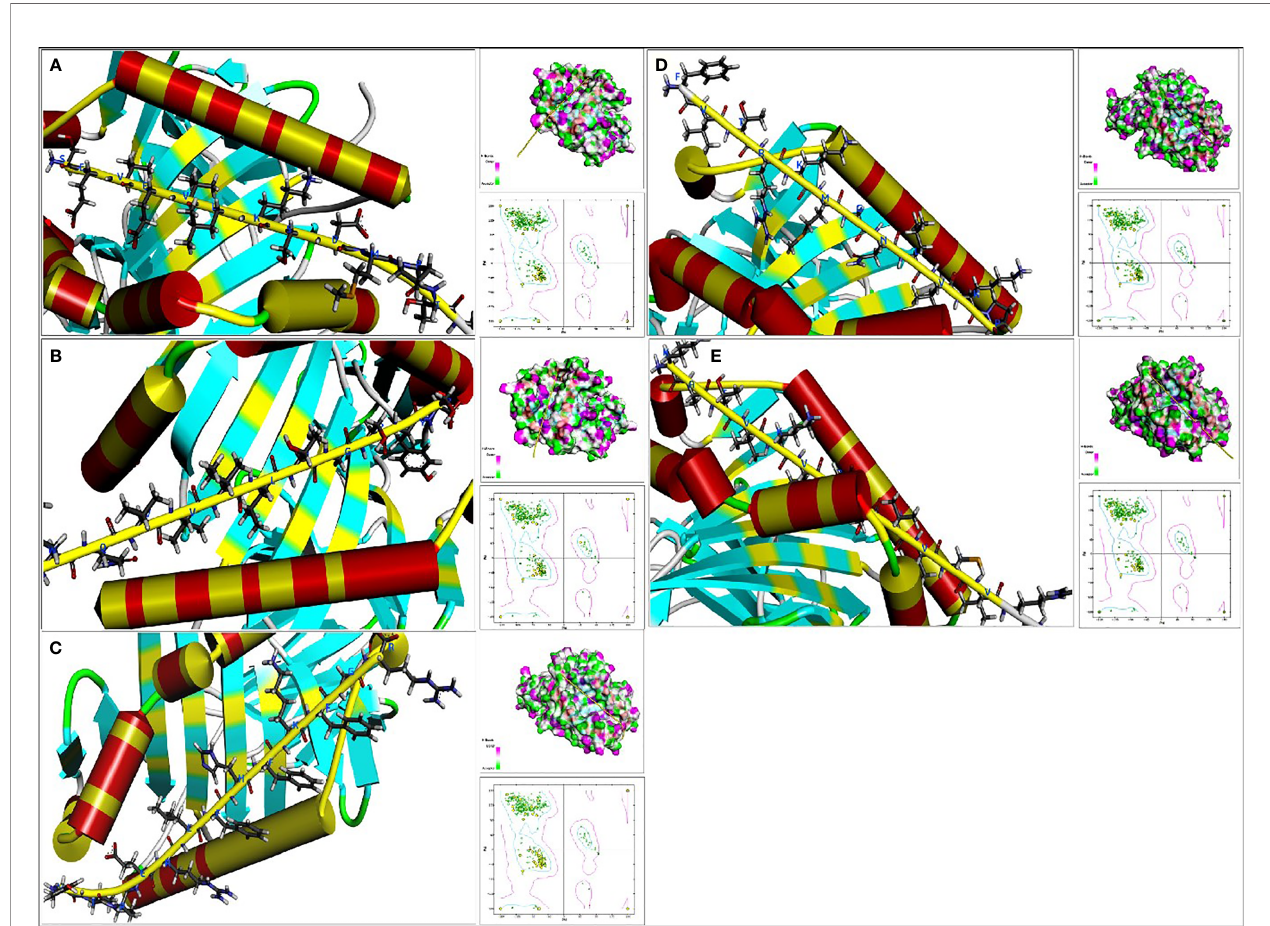
FIGURE 4 | The interaction microstructure between antigen peptide and HLA-DRB1. The (A) was Pose 13 , the (B) was Pose 24 , the (C) was Pose 2, the (D) was Pose 20 and the (E) was Pose56. The yellow chain represents the antigen peptide and the blue abbreviation is the amino acid involved in the interaction. Concurrently there are Hydrogen bond model chart and Ramachandran plot on the right of this Figure. (For understanding the reference color in remark of the fi gure clearly, please readers refer to the web version of this